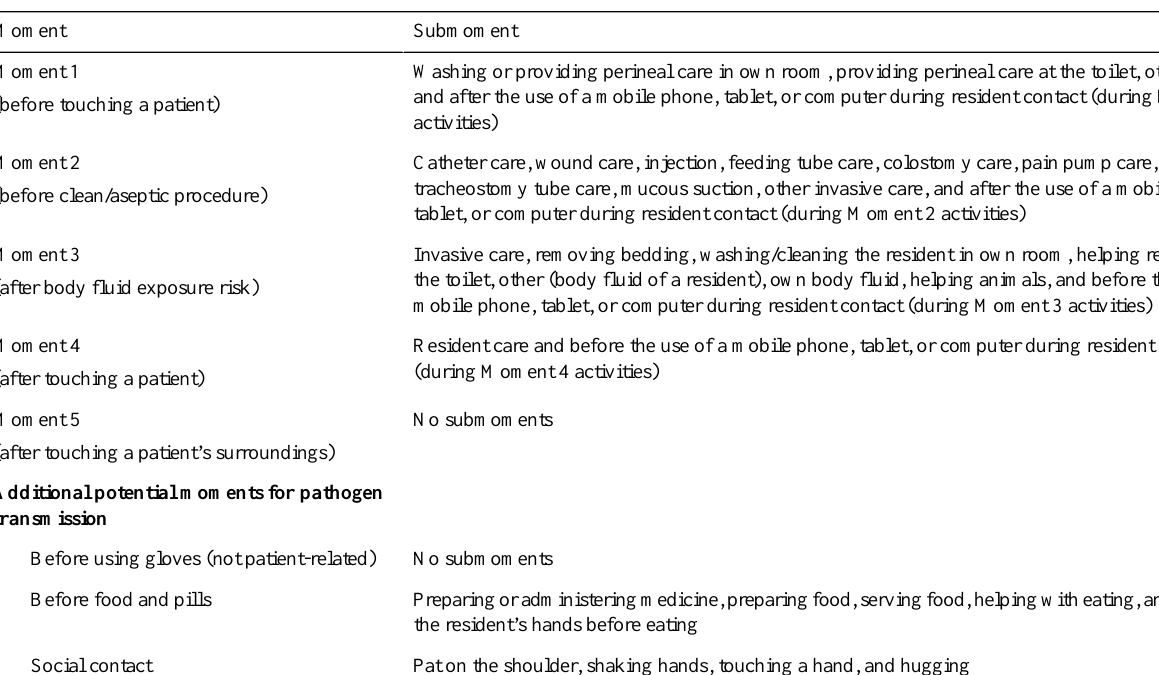
Table 3. Moments and submoments for hand hygiene compliance documentation.